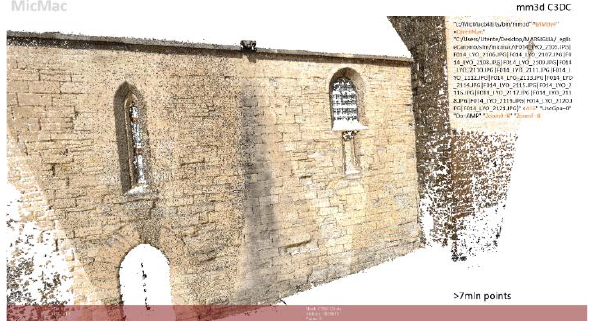
Figure 6. Dense Image Matching phase.